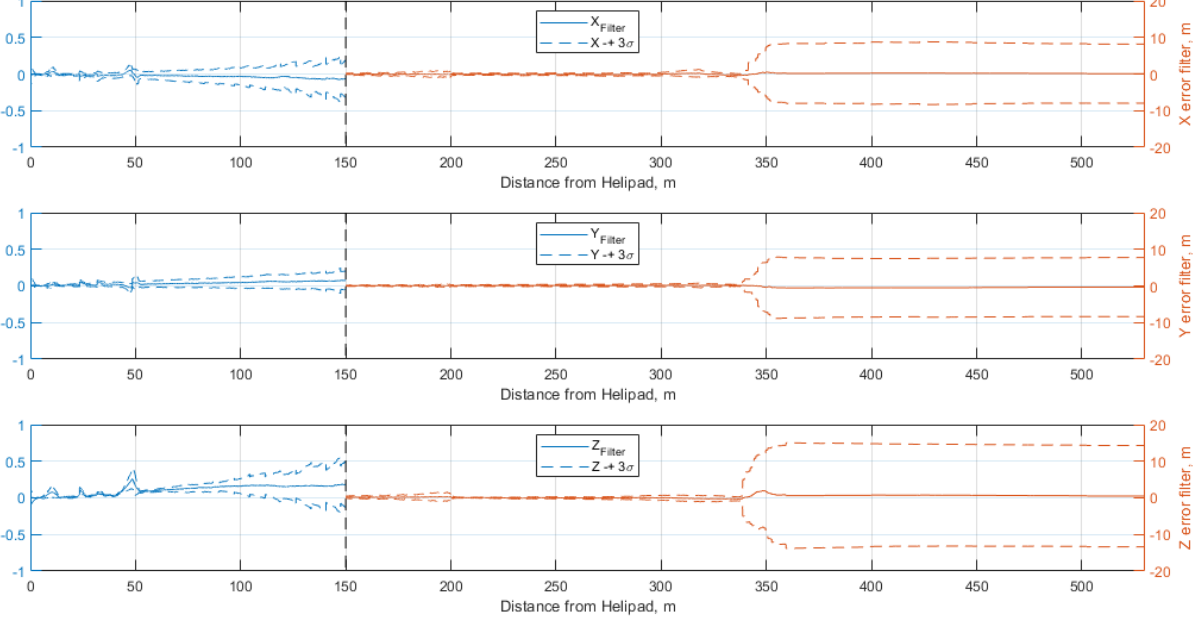
Figure 16. EKF position estimates errors average over 50 simulations and 3 − sigma bounds. 3 − stepped landing trajectory at night-time. The plot scale is increased in the last 150 m to better show the errors in the final phase of the approach.